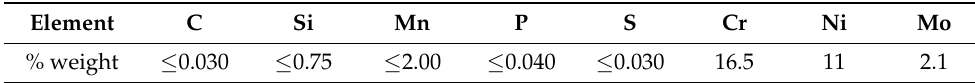
Table 1. Nominal chemical composition of 316L stainless steel.